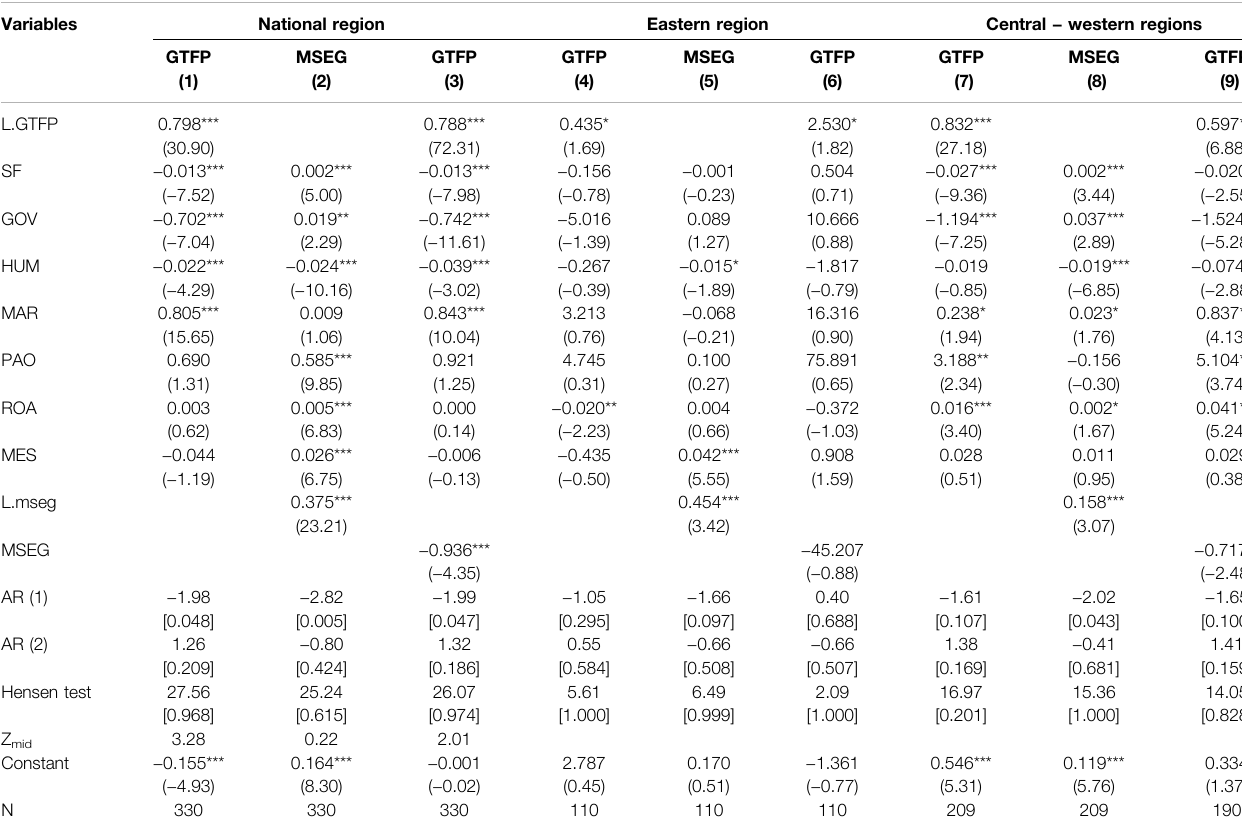
TABLE 9 | Test results for the robustness of mediation effects. Variables National region Eastern